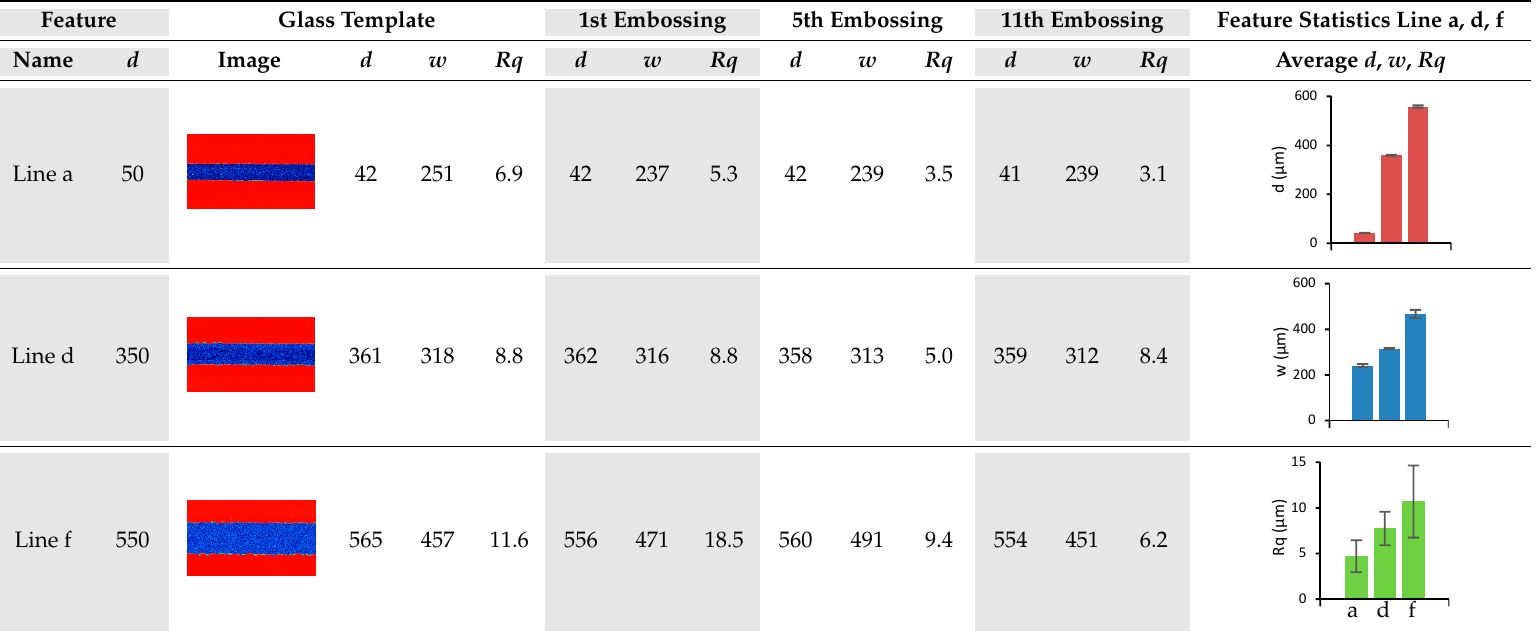
Table 4. Embossing results for substrates after embossing process cycles one, five and eleven.